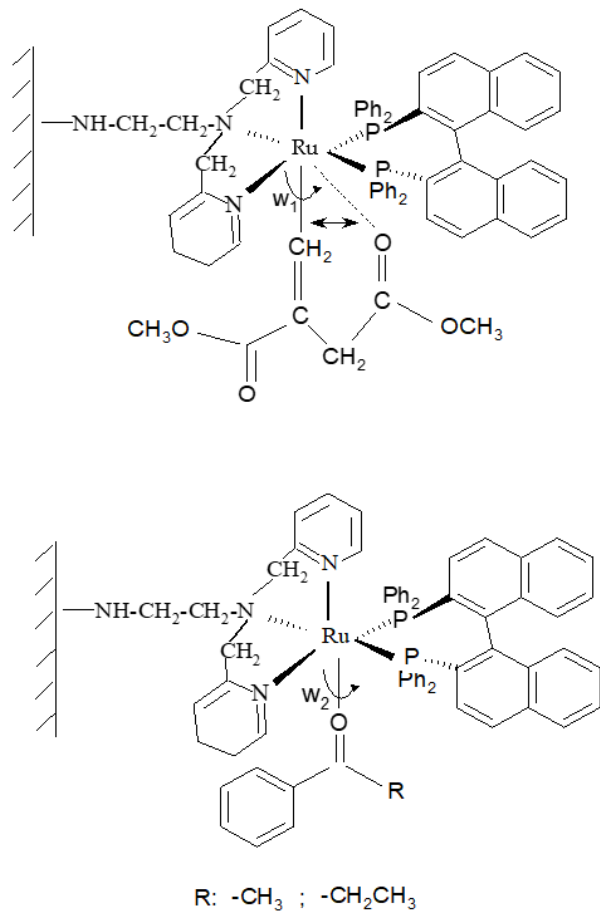
Figure 2. Stabilized conformations on the AlPO 4 -Sepiolite@ 1 complex, of dimethylitaconate by secondary interaction of orbitals and of carbonyl groups by steric effects of the substituent groups.